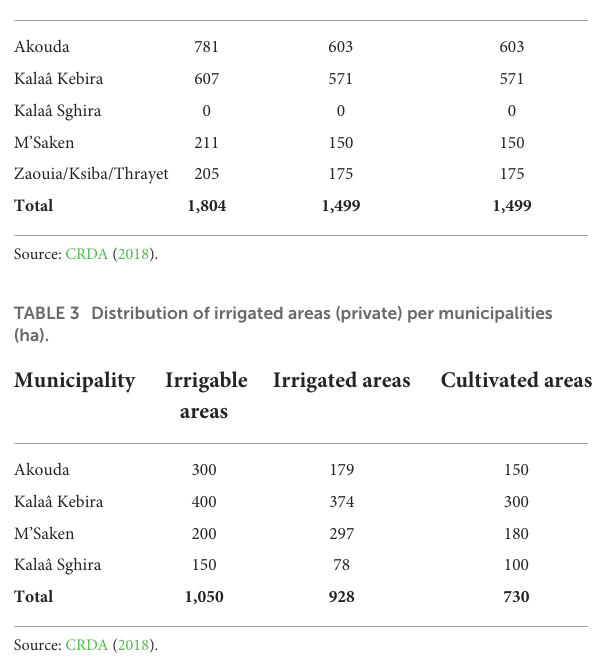
TABLE 2 Distribution of irrigated areas (public) per municipalities (ha). Irrigated areas Cultivated areas Municipality Irrigable areas